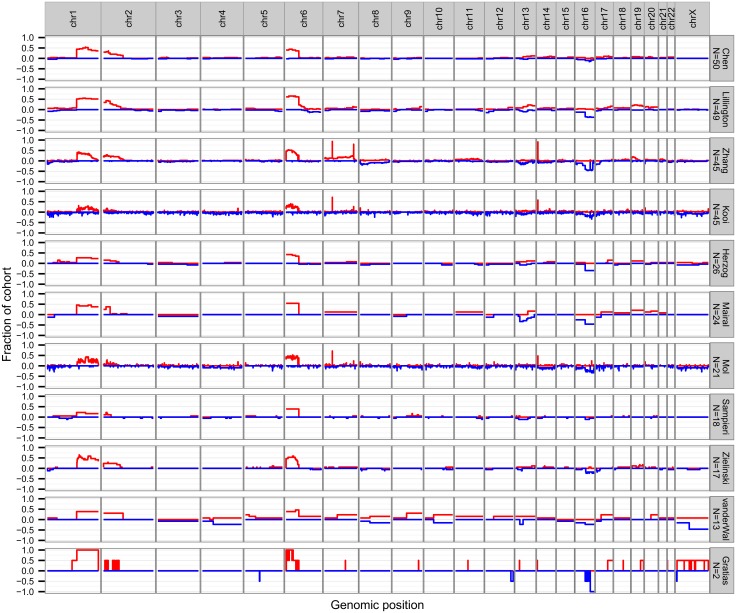
SCNA frequencies per study.Genome-wide SCNA-frequencies (DNA copy number gains in red, losses in blue) detected in primary retinoblastoma samples in our current study (Kooi, N = 45) and in ten published studies. Studies are ordered by sample size where the largest study is placed at the top.